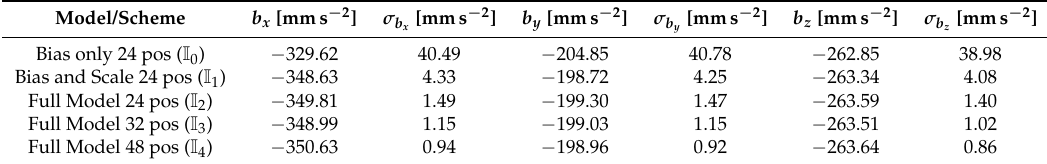
Table 2. Estimated biases of IMU calibration.